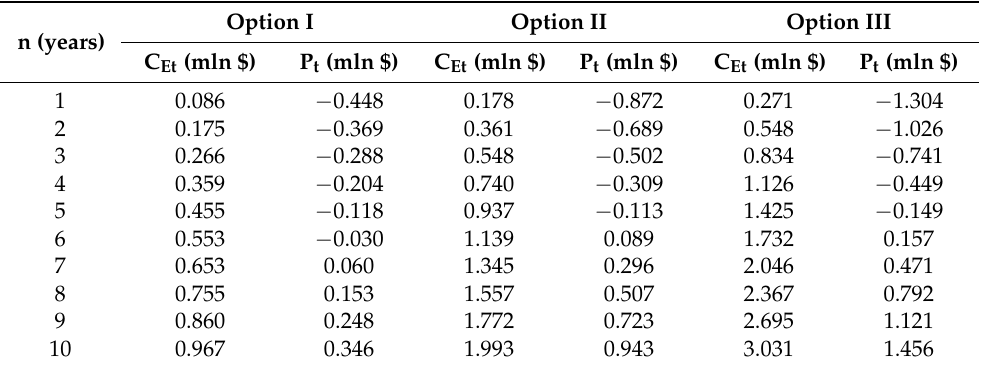
Table 11. ESD total cost and profit for a 10 years period with the new energy price and additional profit from reduction of the CO 2 emission.